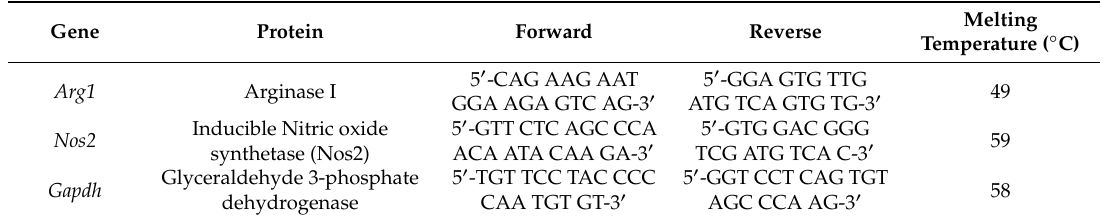
Table 2. Primers used for RT-PCR